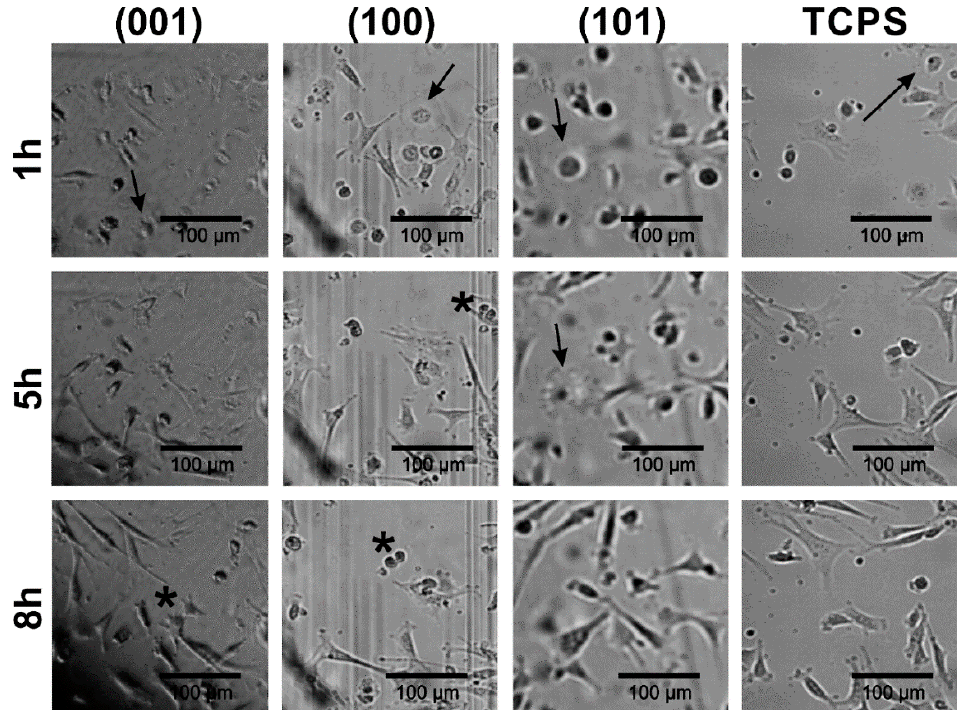
Figure 4. The fibroblast attachment to GAp plates of different crystallographic orientations compared with the reference substrate (TCPS), after 1 h, 5 h and 8 h of incubation. The cells at various stages of cytokinesis are marked with the asterisks. The cells in the beginning stage of cellular attachment to the surface are indicated with the arrows.